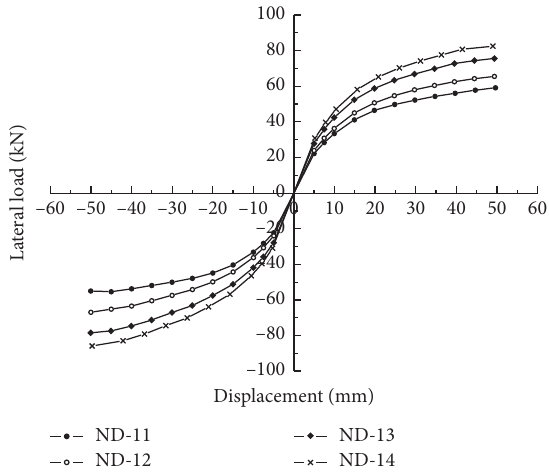
Figure 23: Skeleton curves of slit width 60mm.